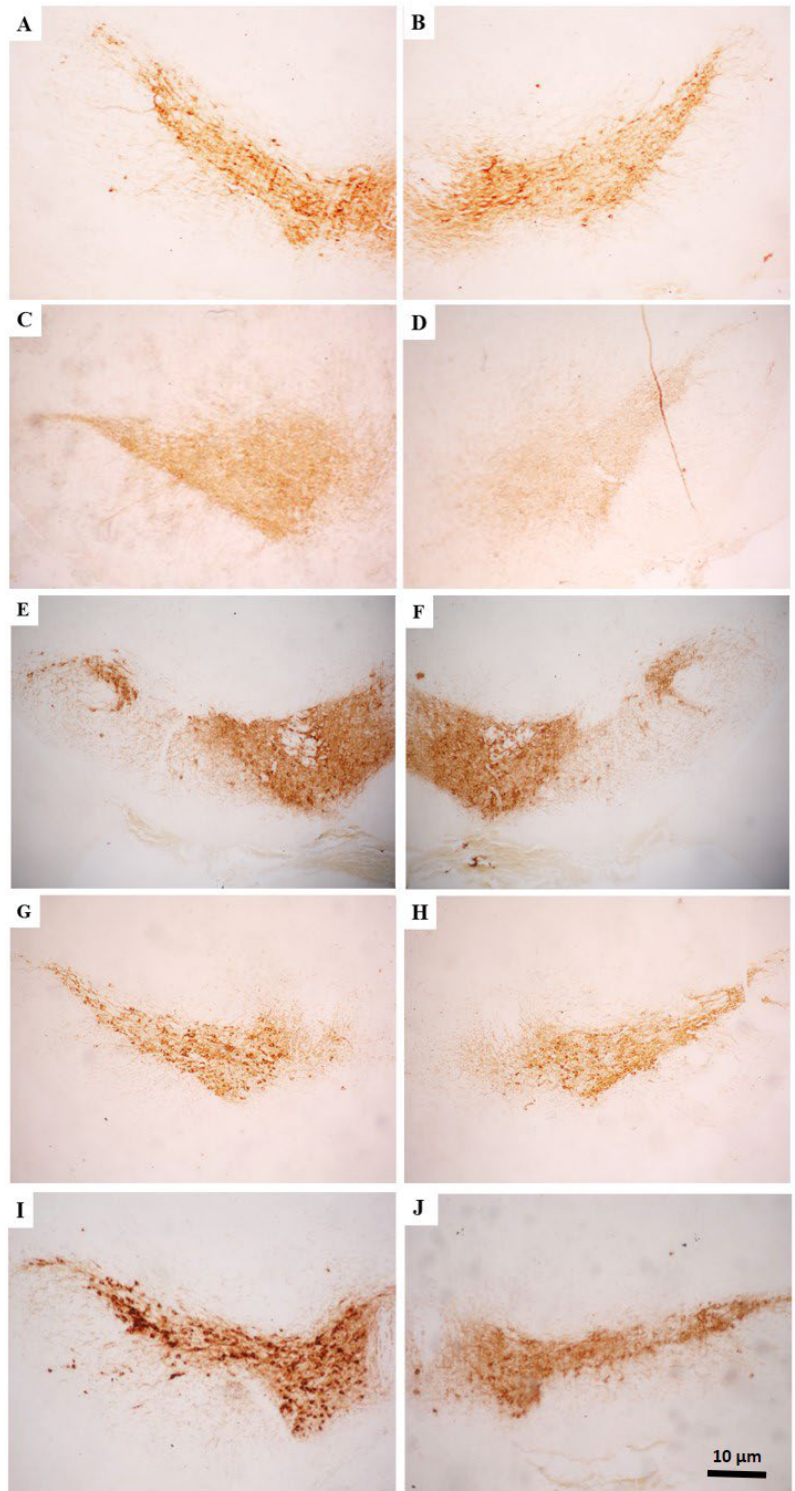
Figure 5. Representative photomicrographs of brain tissue in the substantia nigra pars compacta— SNc—region after immunohistochemistry for TH. The images ( B ), ( D ), ( F ), ( H ), ( J ) represent the injured sides, and the images ( A ), ( C ), ( E ), ( G ), ( I ) represent their respective controls. In ( A , B ): group saline/saline, ( C , D ) 6-OHDA/saline, ( E , F ) 6-OHDA/BV 0.01 mg·Kg −1 , ( G , H ) 6-OHDA/BV 0.05 mg·Kg −1 , ( I , J ) 6-OHDA/BV 0.1 mg·Kg −1 , referring respectively to microinjection intrastriatal and systemic treatment. Magnification of 100×.